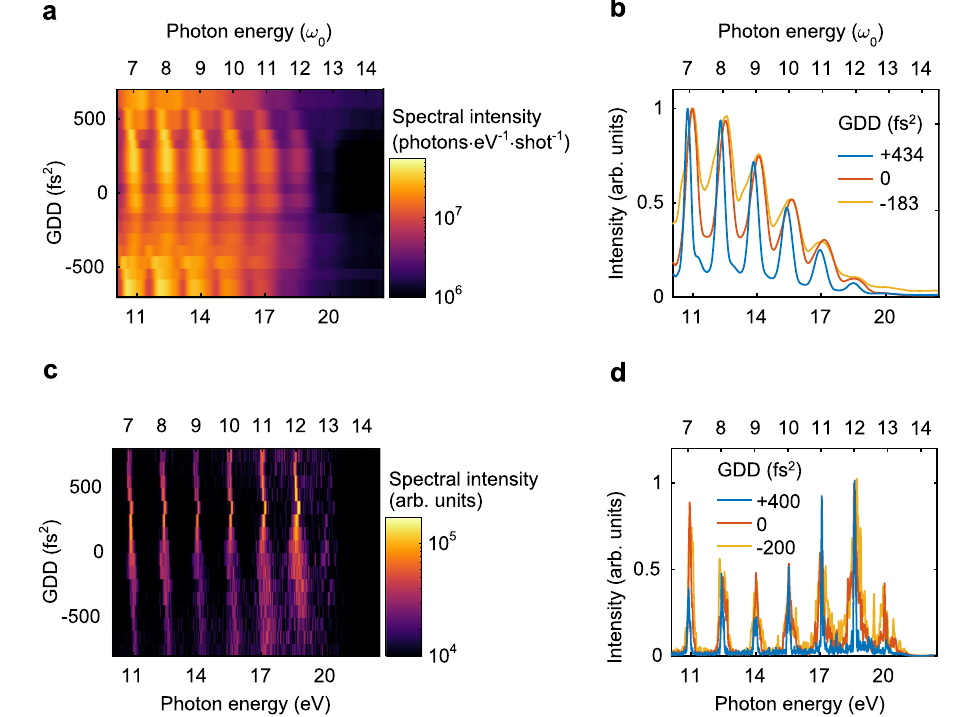
Fig. 3 | Dispersion dependence of CWE from liquid plasma. a Angle-integrated CWEspectraobtainedintheexperimentforthe21differentGDDsofadrivinglaser fi eld. The spectra are the mean values of fi ve independent experiments. b Comparison of three spectra shown in a . Each spectrum was normalised to a maximum intensity between 6 : 5 ω 0 and 14 : 5 ω 0 for better comparison of the